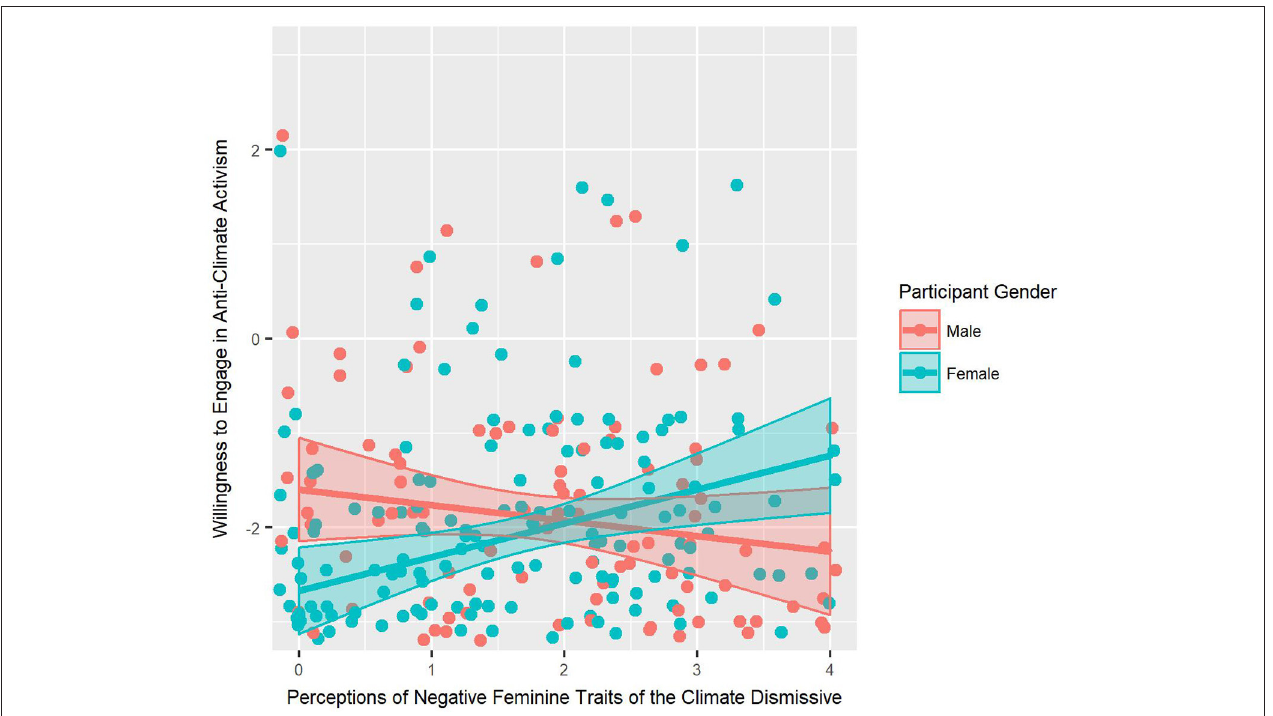
FIGURE 1 | Interactive effect of negative feminine trait perceptions of the climate dismissive and participants’ own gender on interest in engaging in anti-climate activism (Study